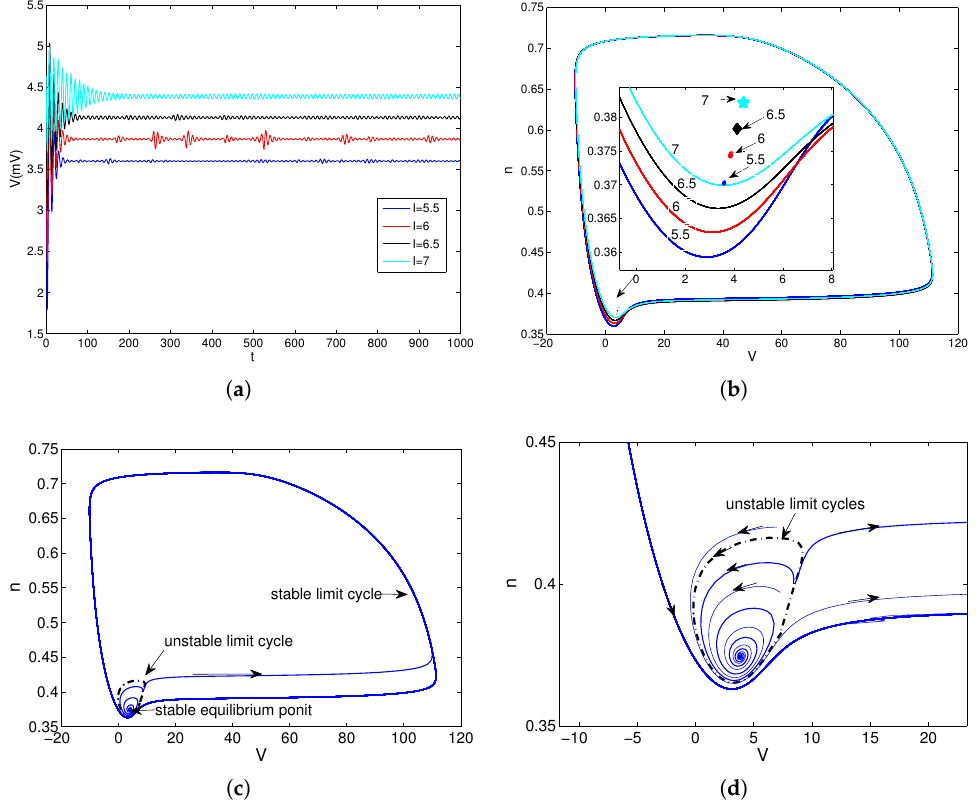
Figure 5. The convergent behaviors of model (28) about parameter I . ( a ) Response curve of trans- membrane voltage V for I = 5.5, I = 6, I = 6.5 and I = 7. ( b ) Trajectories in V − n phase plane for I = 5.5, I = 6, I = 6.5 and I = 7. ( c ) Trajectories in V − n phase plane for I = 6. ( d ) A locally enlarged view of ( c ) for I =